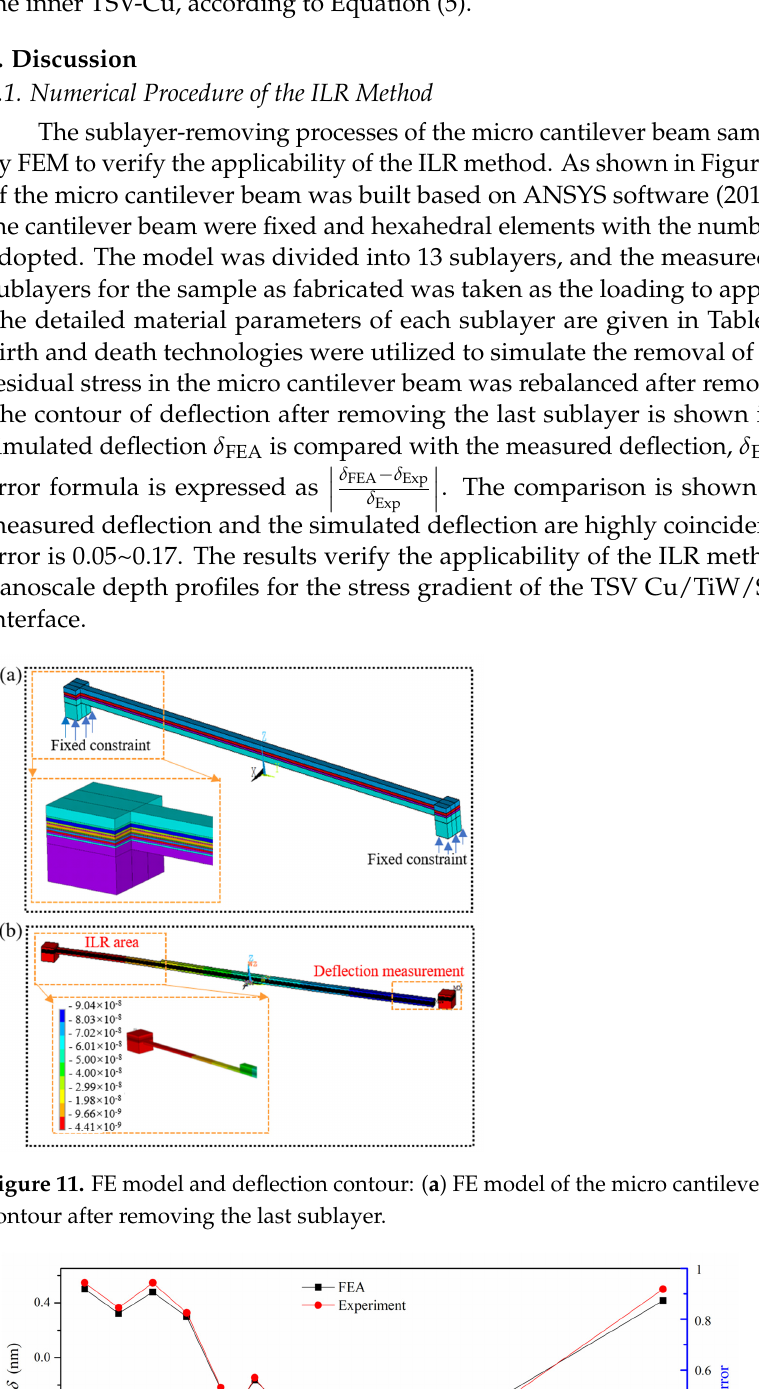
Figure 12. The comparison of the measured deflection and simulated deflection.